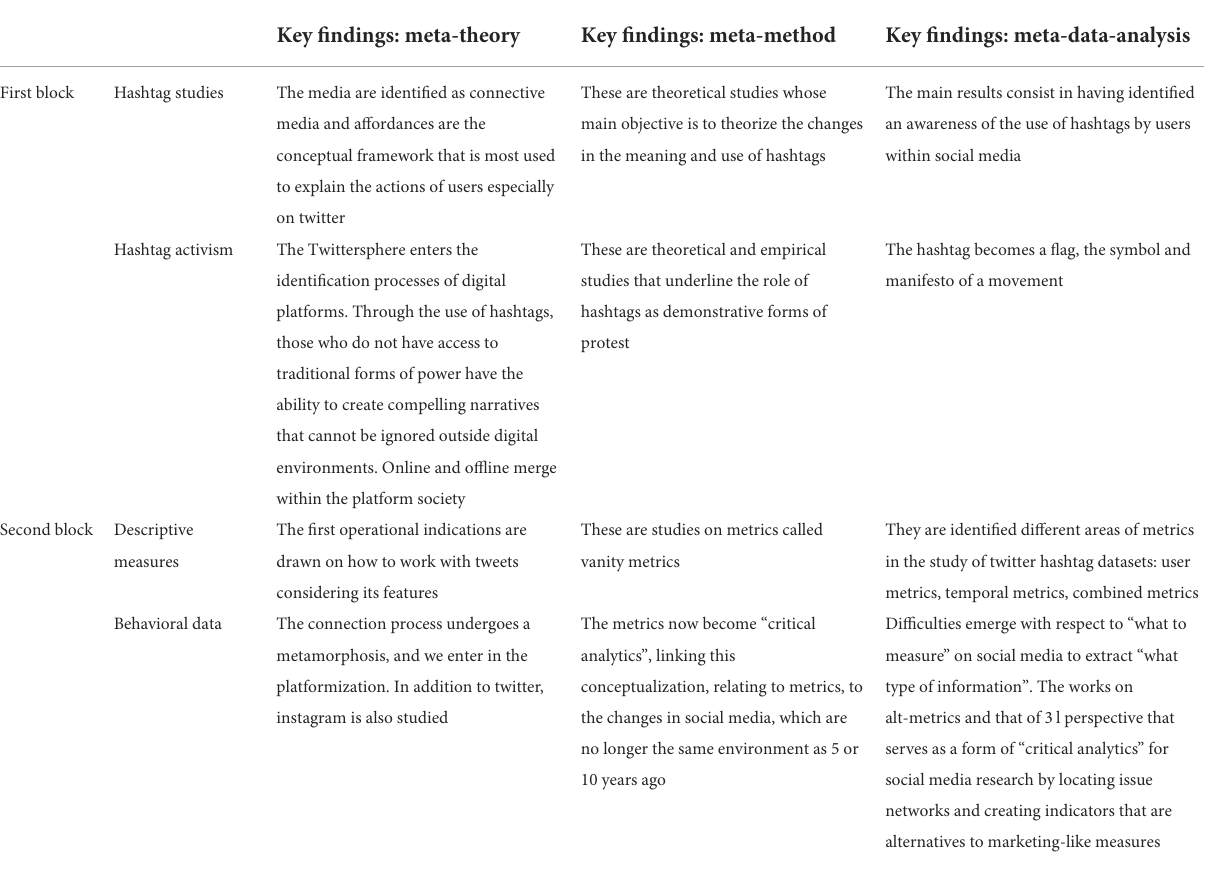
TABLE 1 Summary of the results of the meta-study.